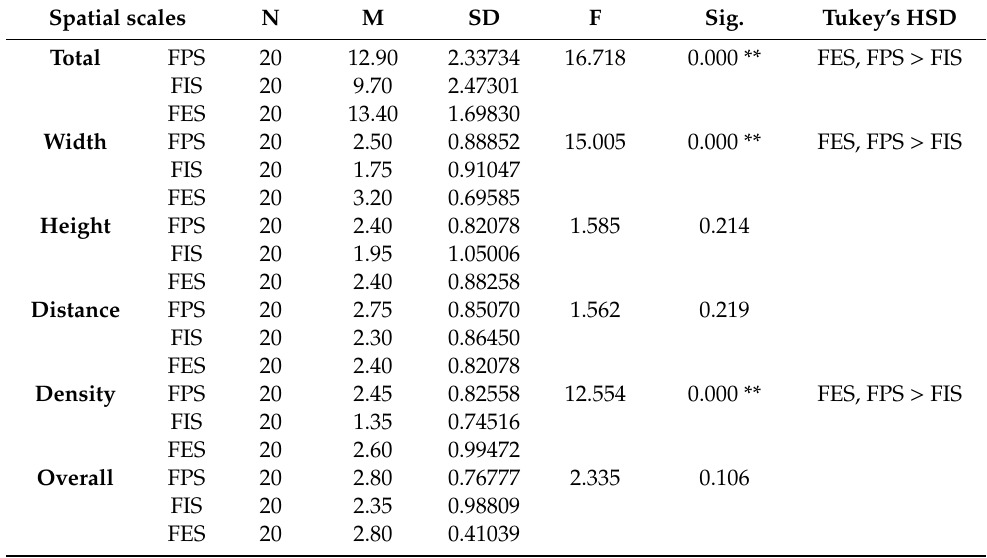
Table A3. E ff ect of bamboo forest space on spatial scales across the experimental groups (dependent variables: